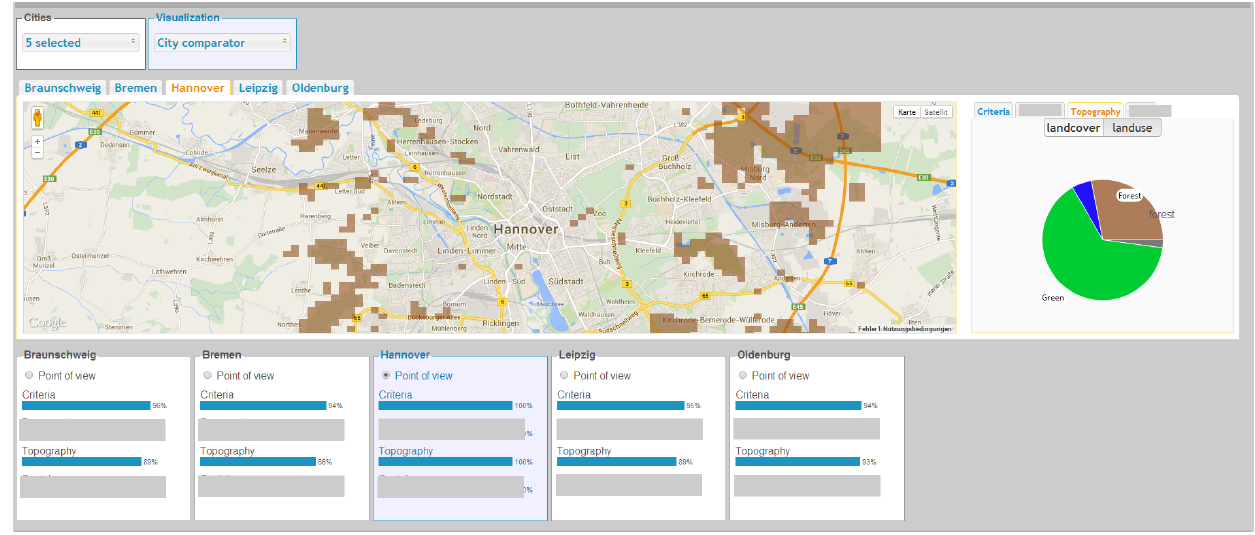
Figure 7 . City-based